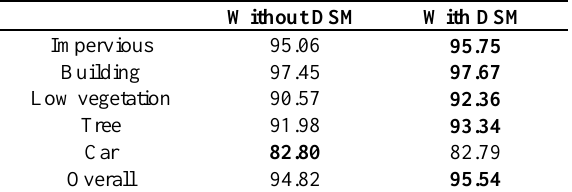
Table 2. F1 scores for each class and overall accuracies comparison between approach without DSM and approach with DSM (%).